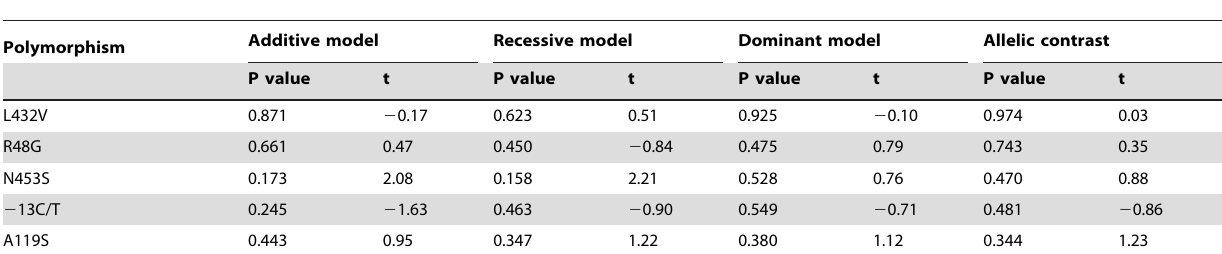
Table 4. Egger’s linear regression test to measure the funnel plot